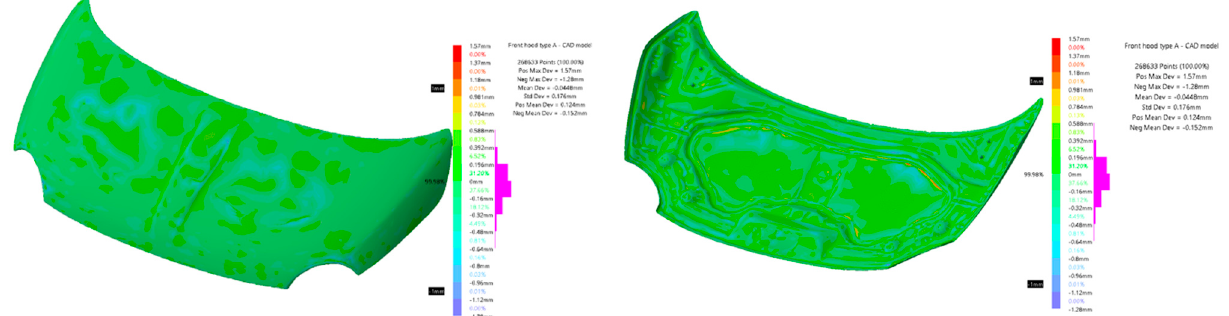
Figure 10. CAD model—scanned model comparison for hood “A”.